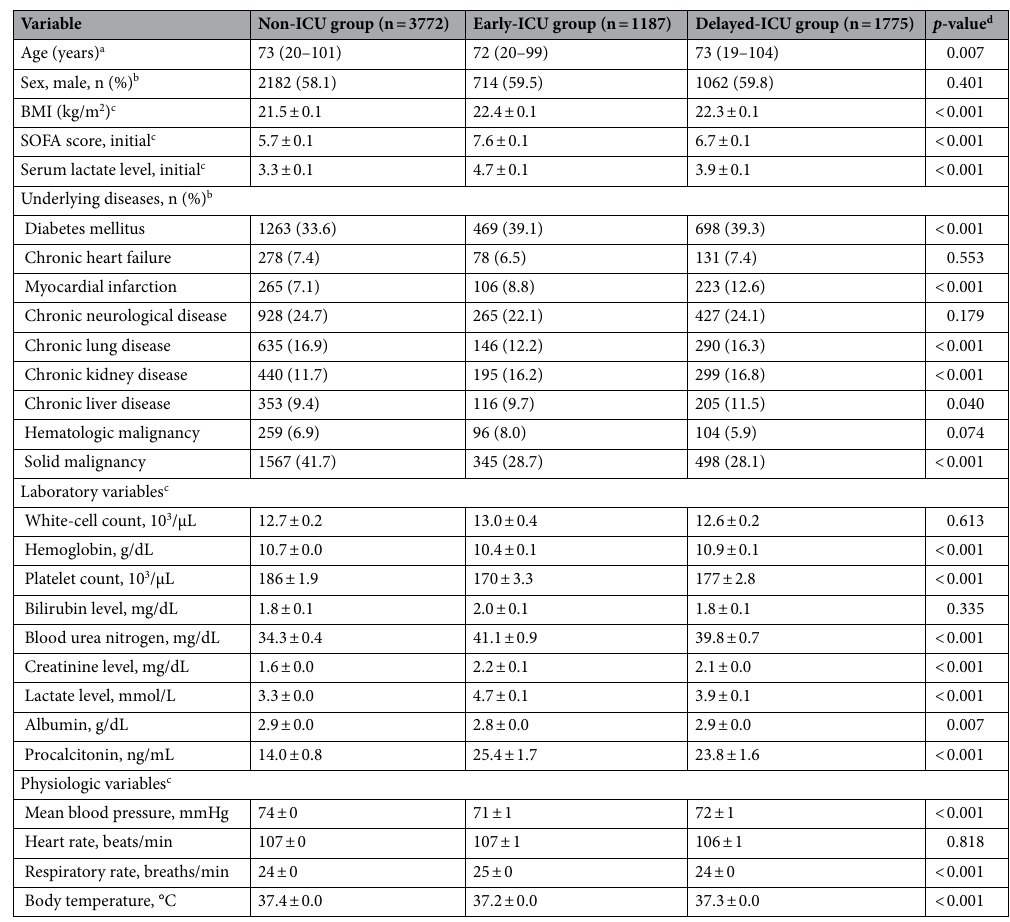
Table 2. Baseline characteristics in the non-ICU, early-ICU, and delayed-ICU groups. a Values are presented as the median (range); b Values are presented as number of subjects (percentage); c Values are presented as the mean ± SE; d Differences in three groups were tested with two-tailed Kruskal–Wallis test for continuous variables and two-tailed chi-squared test for dichotomous variables. BMI body mass index, ICU intensive care unit, SOFA Sequential Organ Failure Assessment score, Lac‑SOFA score sum of SOFA score and Lac-score, SE standard